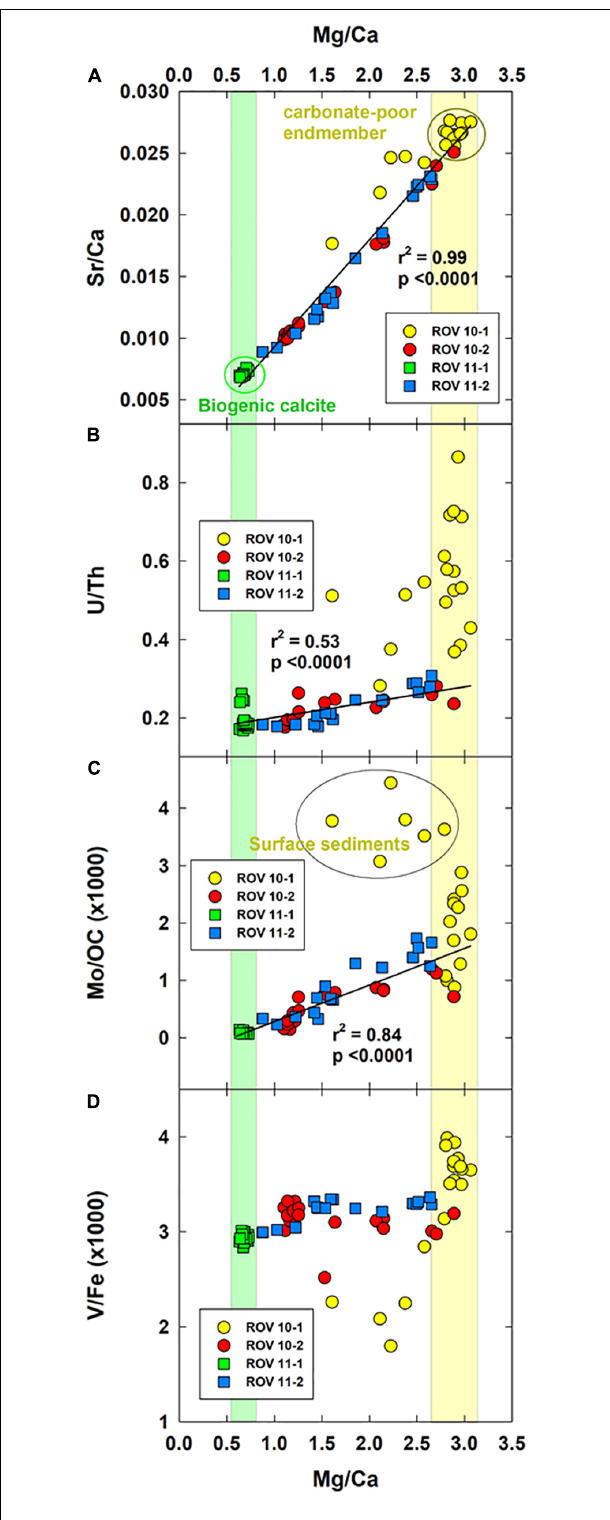
FIGURE 7 | Crossplots of Sr/Ca (A) , U/Th (B) , Mo/OC (C) and V/Fe (D) as the function of Mg/Ca. In (A) , the top four cm sediments at station ROV 10-1 was excluded from the regression. In (B,C) , the regression was performed only on ROV 10-2, 11-1, and